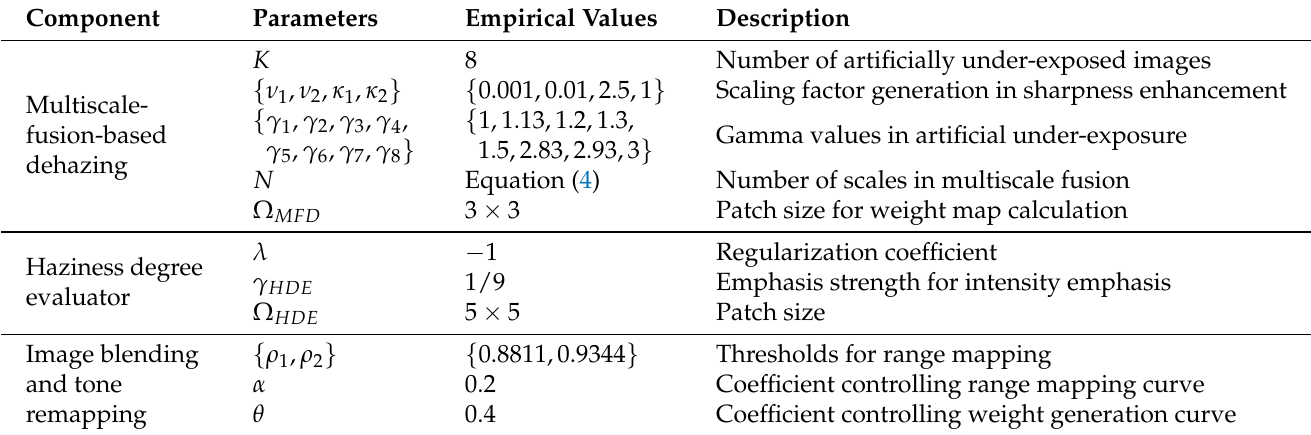
Table 3. Employed parameters and their corresponding empirical